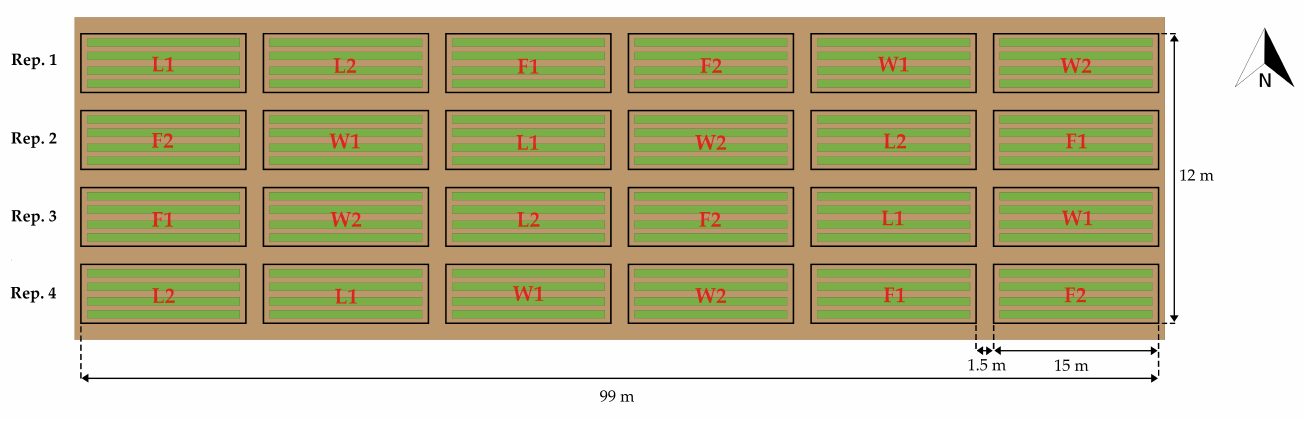
Figure 1. RGB representation of the data and the designated plots for ( a ) 2019 and ( b ) 2020 experimental designs. Note the plots’ bounds in